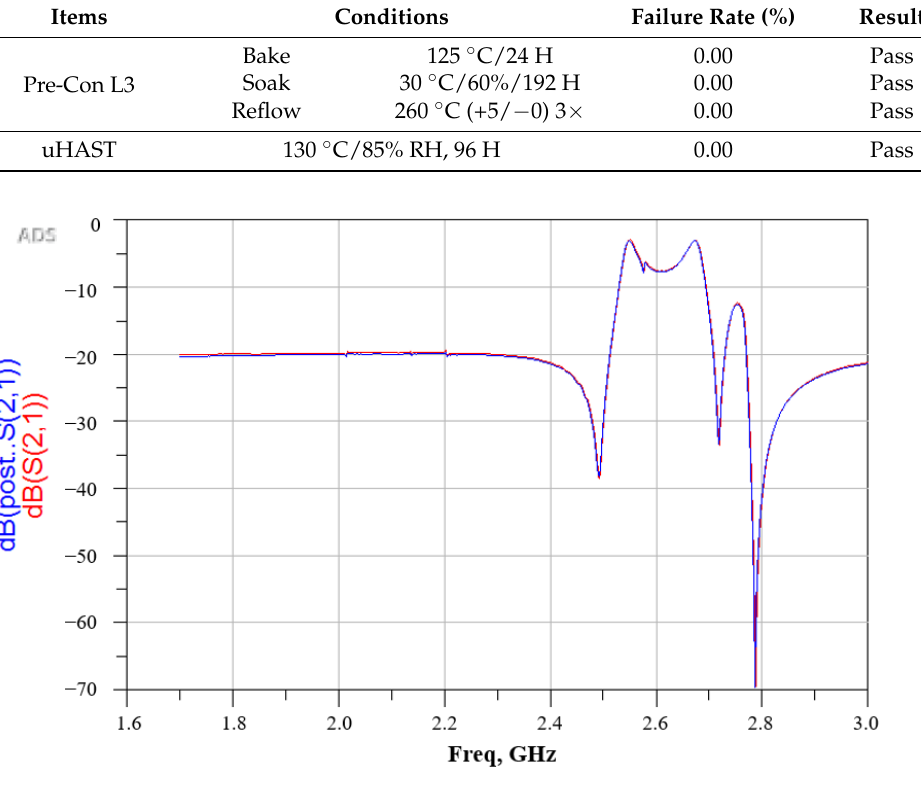
Figure 15. SEM image of the RDL of a single package after uHAST 96 h. ( a ) Cross-sectional picture of the SAW Device WLP with solder ball. ( b ) Interconnection structure of the chip’s pad and the solder ball by TFV. ( c , d ) indicate the interconnection structure on the left and right side of the chip’s pad, respectively. 5. Conclusions In this paper, a construction procedure for a 3D WLP for a SAW filter using non- photosensitive dry film lamination and laser drilling technologies was presented. Due to its effective packaging process, it can provide a low-cost alternative to a conventional packaging method for smaller SAW filter applications. The main conclusions are de- scribed as follows.